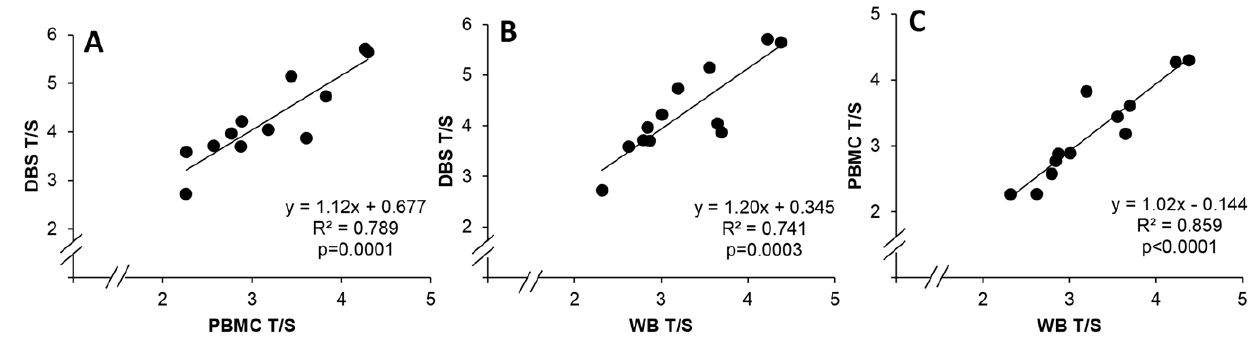
Figure 7 . Comparison of T/S measurements in DBS, PBMC and WB samples . T/S ratios were determined for DNA from DBS (n=12), PBMC (n=12) and WB (n=12) samples made from a single blood draw from 12 distinct individuals. Pearson’s R 2 and p values are shown.